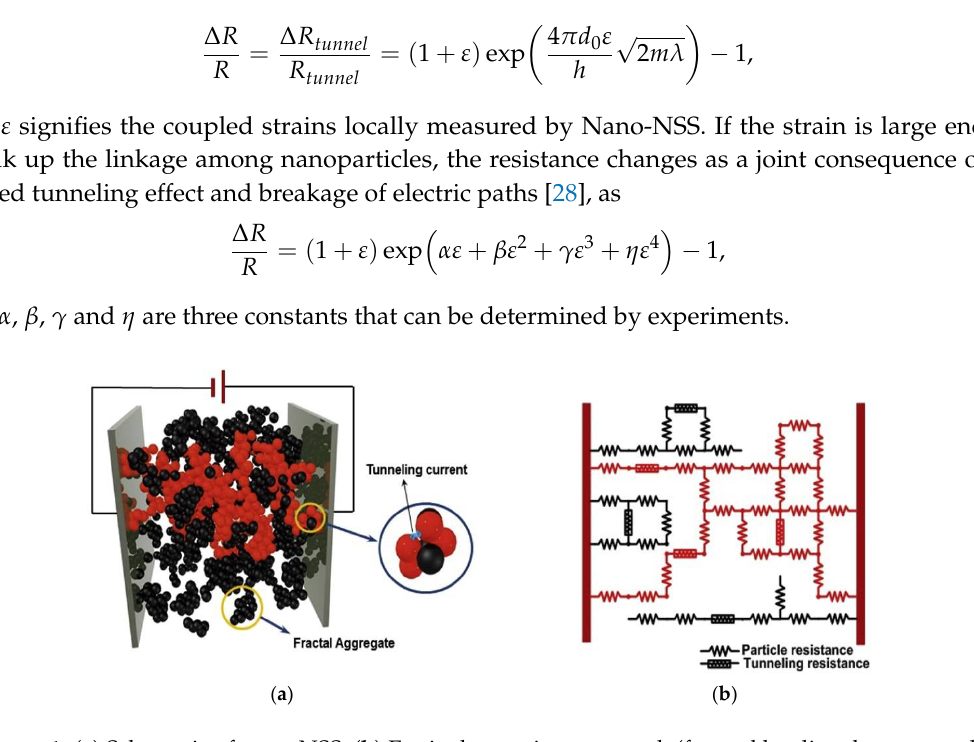
Figure 1. ( a ) Schematic of nano-NSS; ( b ) Equivalent resistor network (formed by directly-contacted nanoparticles and indirectly-contacted nanoparticles via the quantum tunneling effect).